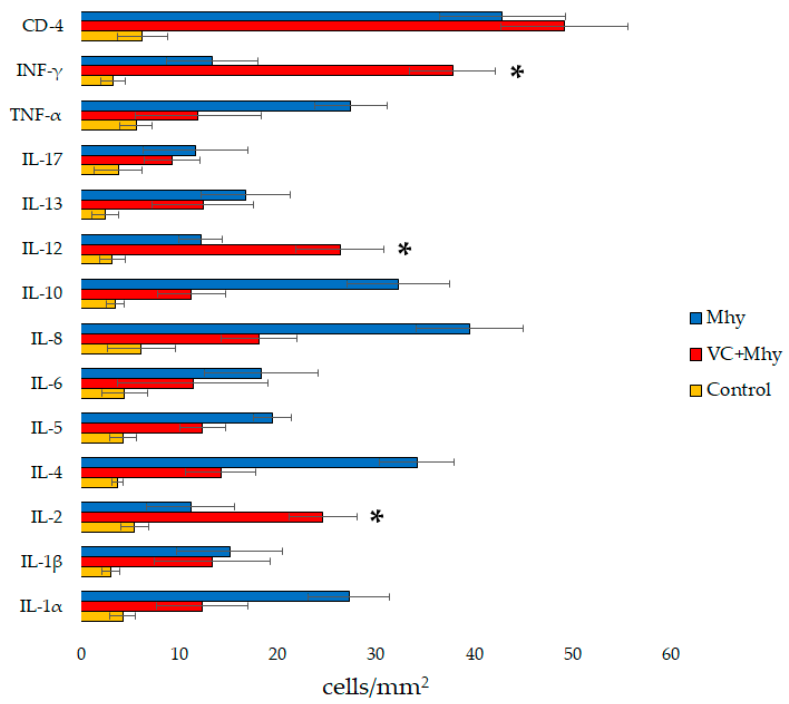
Figure 2. Immunohistochemical results, expressed as mean ± standard deviation of positive cells per mm 2 , in Control (un-vaccinated/uninfected), VC + Mhy (vaccinated/infected), and Mhy (un-vaccinated/infected) pigs. Significant (*) overexpressed Th1-type cytokines (IL-2, IL-12 and INF- γ ) in vaccinated/infected pigs in relation with both un-vaccinated/uninfected and un-vaccinated/infected groups.